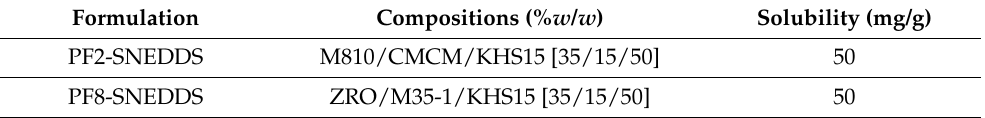
Table 4. The propofol dissolved in the optimized formulations at 50 mg per gram of formulation. Formulation